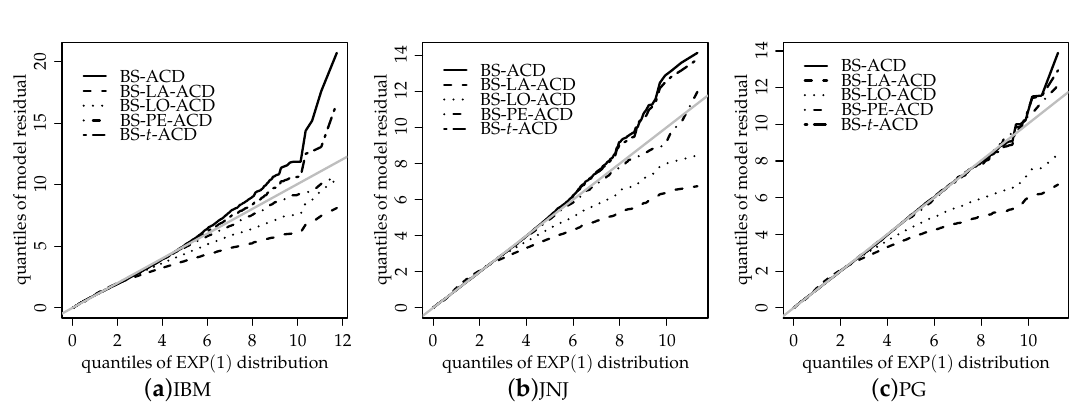
Figure 4. QQ plot for the Cox–Snell residual with the indicated data sets.